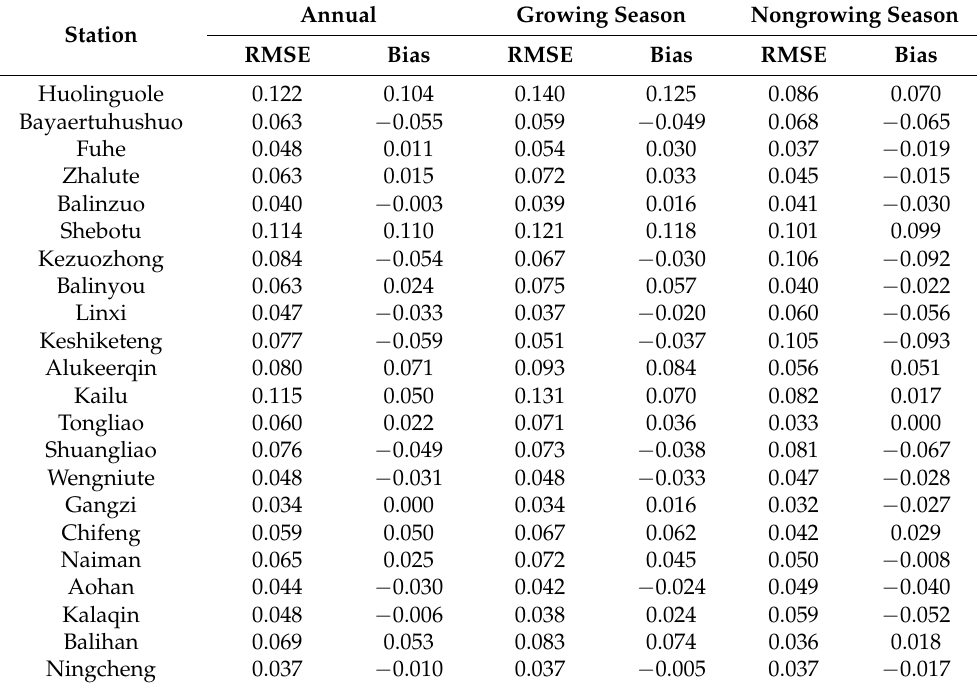
Table 2. RMSE and bias from the SMAR predictions compared to observations at in situ sites during the whole year, growing season and nongrowing